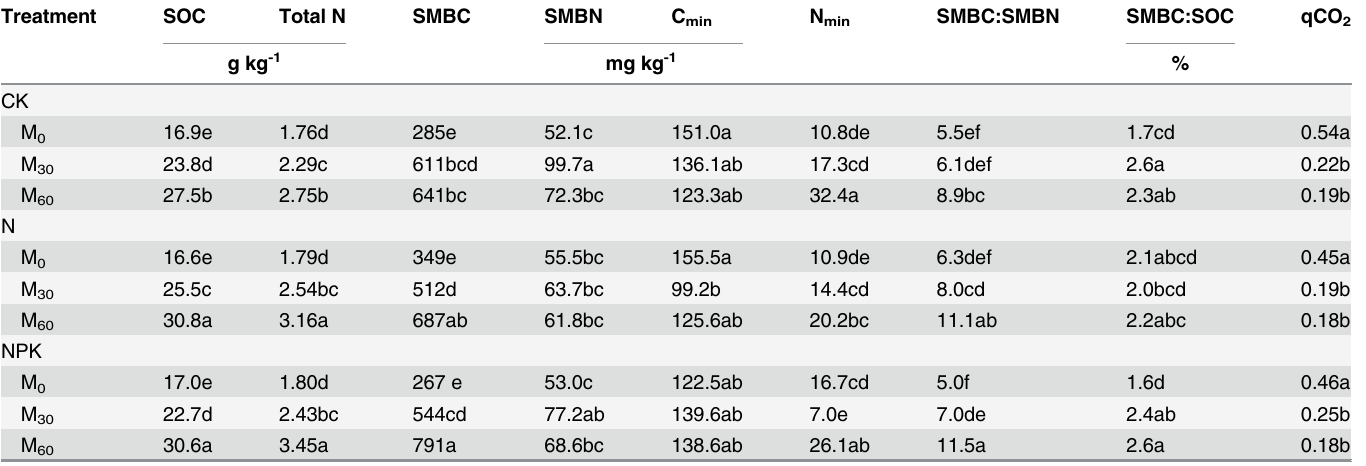
Note: Different letters indicate signi fi cant differences at 5% probability level under different treatments.